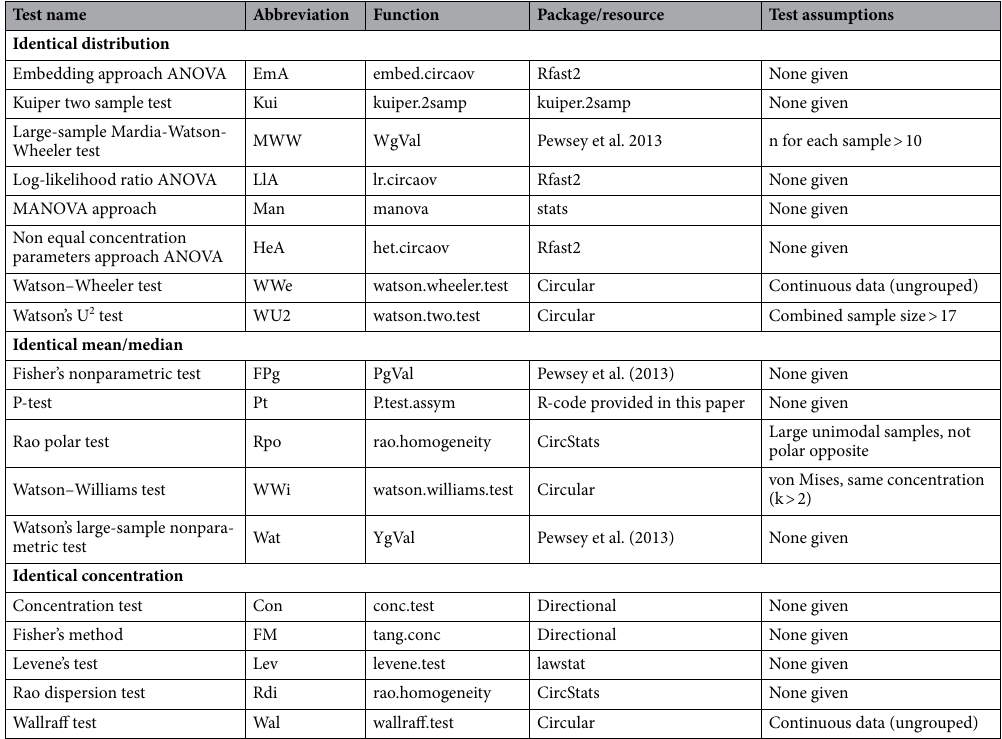
Table 1. List of tests used, including the functions and packages used, as well as the respective null hypothesis and test